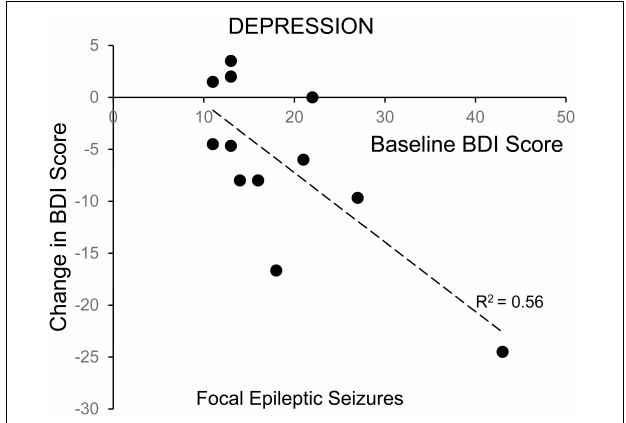
FIGURE 4 | Correlation of change in depression symptoms with baseline symptom severity for patients with focal epileptic seizures. The change in depression symptoms for individual patients, as evaluated with the Becks Depression Index-II, in the 24-h following a focal epileptic seizure, is plotted as a function of their baseline symptom severity. The correlation was statistically significant (Pearson p = 0.0048).